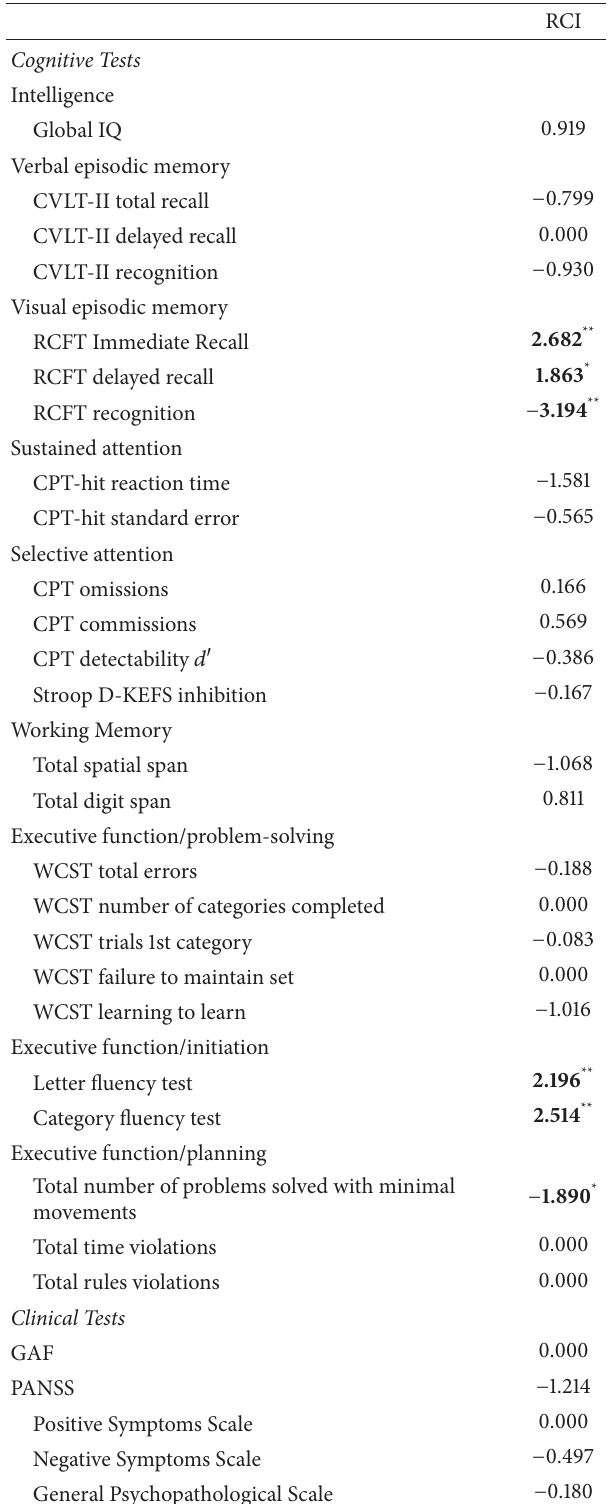
Table 3: Reliable Change Index (RCI) for the neuropsychological